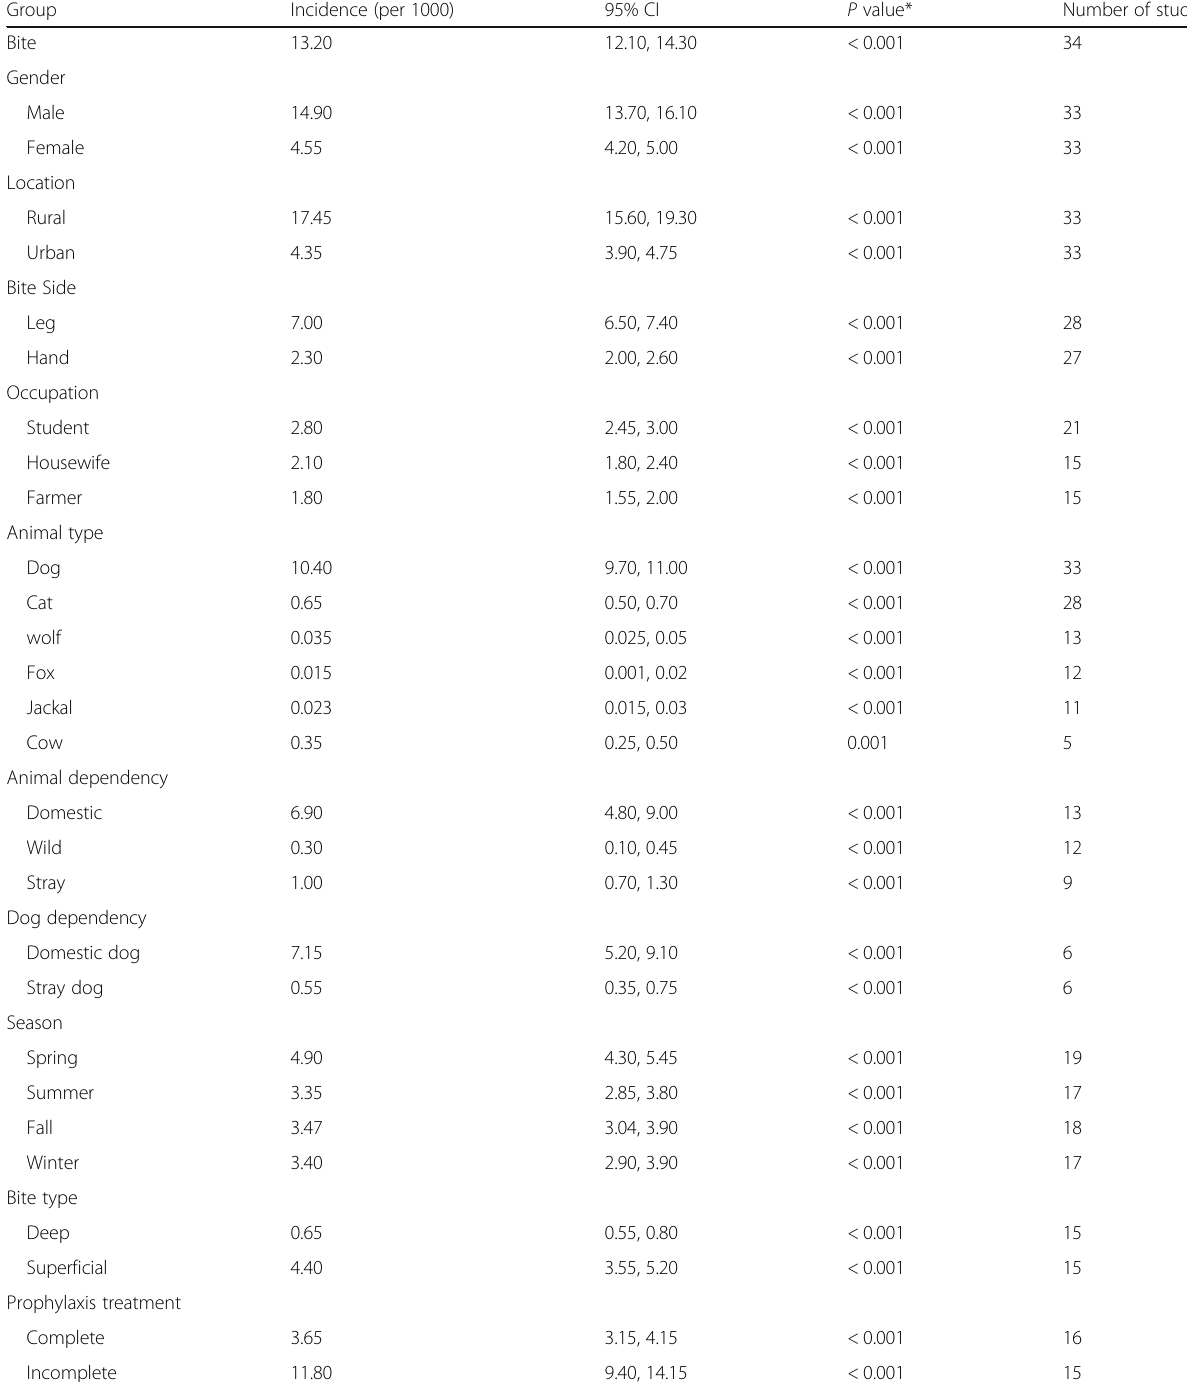
Table 2 The incidence rate of variables in related subgroup